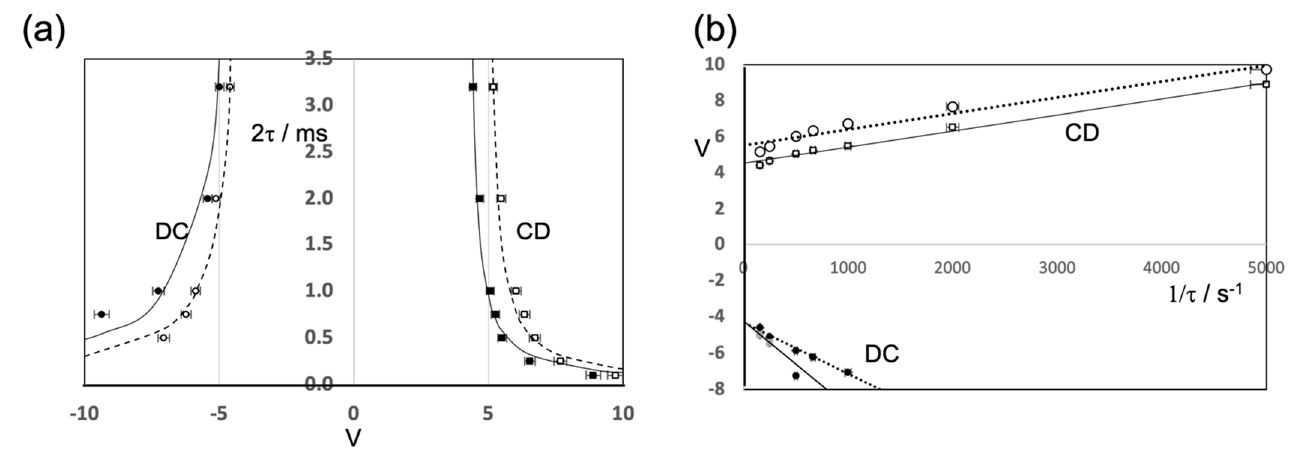
Figure 4. Experimental latching curves for the high flexoelectric liquid crystal nematic mixture MLC6204-000 in a 5.0 μ m ZBD cell at 30 °C showing ( a ) applied pulse width (2 τ ) versus the amplitude of pulse required to latch and ( b ) the (2t) − 1 V plot for the same data. Both the onset of latch and the total latch are indicated, by empty for mainly D and filled markers for mainly C, respectively. Positive pulses indicate the latch from continuous to defect state and negative pulses indicate the latch from defect to continuous. Error bars in voltage are taken as ±3% and the temporal errors are not visible at this scale. The best fits to Equation (5) are shown as continuous lines, with the fitted parameters listed in Table 1. Table 1. Fitting parameters for Figure 4.